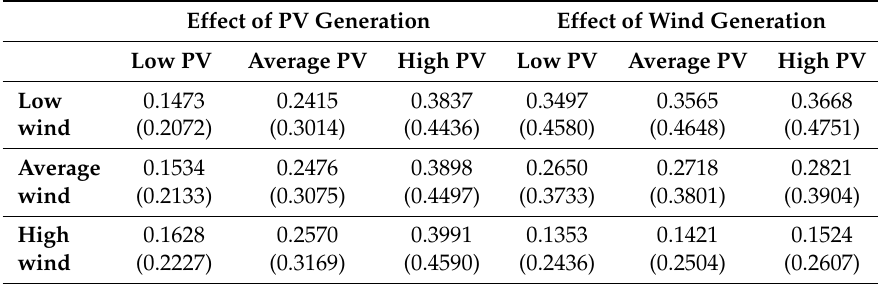
Table 2. Results from the Ridge Regression at α = 200: displayed are the effects of one additional unit of PV and wind generation, respectively, for different levels of PV and wind generation. Values including the effect of flow-based market coupling are in parentheses. Source: own